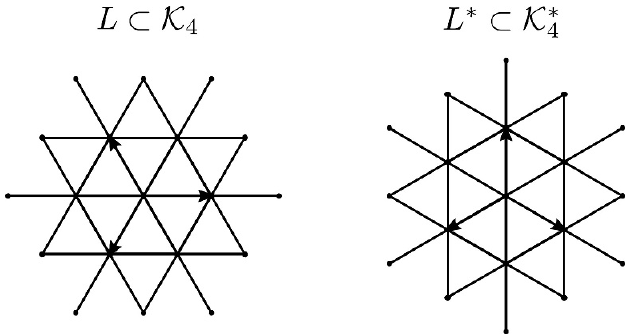
Figure 11 . The lattice of points with integer Mandelstam variables, L , and its dual lattice, L (cid:3) .